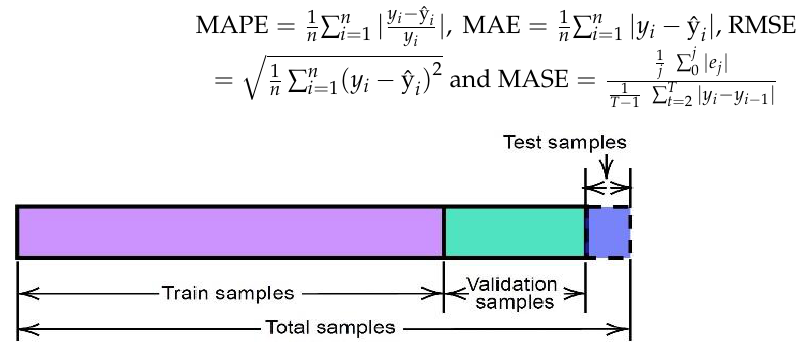
Figure 4. Method of performance evaluation and validation.